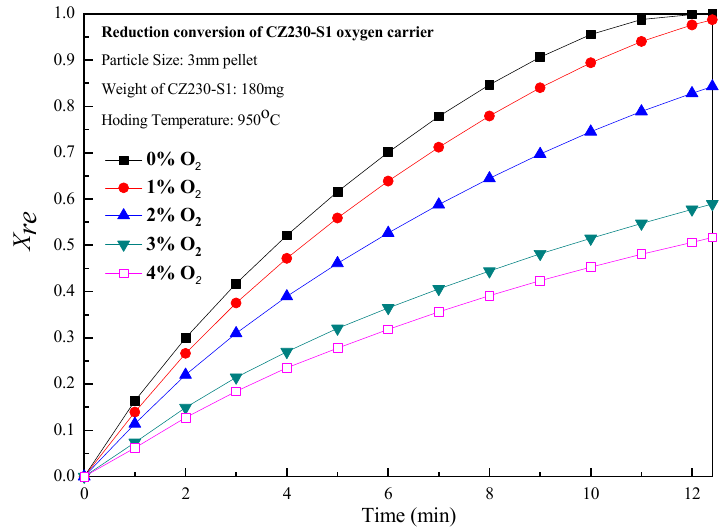
Figure 8. Effect of oxygen concentration on the conversion of CZ230-S1 reduction in a TGA.